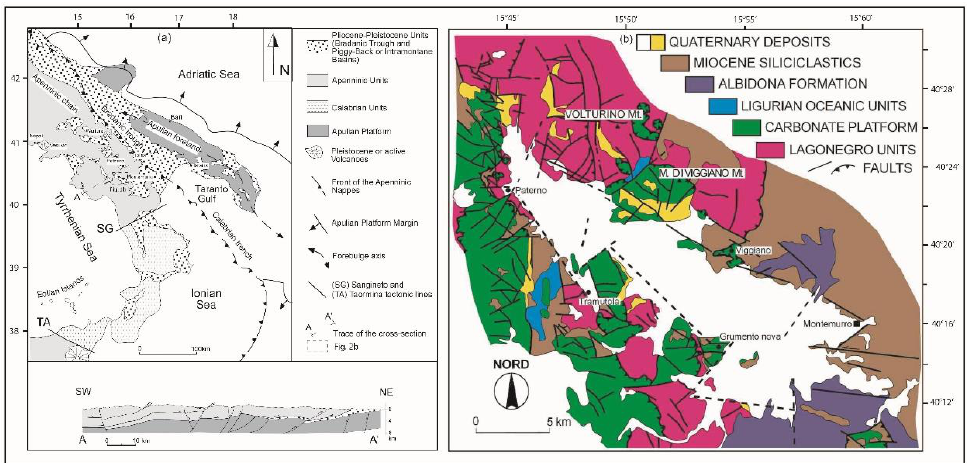
Figure 2. (a) Geological sketch map of the southern Apennine and geological cross section [22 – 24]; (b) geological map of the Agri Valley basin [25].